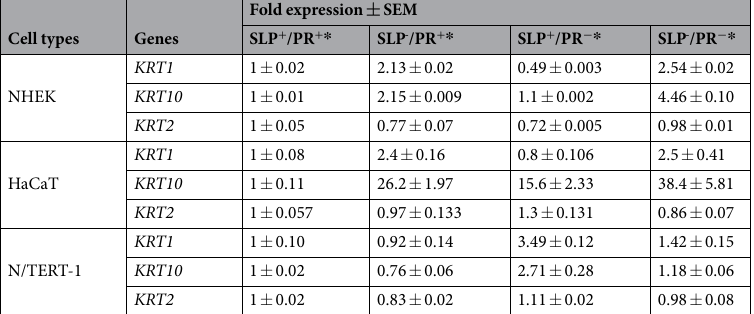
Table 1. mRNA expression of KRT1 , KRT10 and KRT2 in four different culture conditions in NHEK, HaCaT and N/TERT-1 cells. * SLP + /PR + : complete FCS with phenol red (PR); SLP − /PR + : charcoal stripped FCS (CS-FCS) with PR; SL + /PR − : complete FCS without PR; SLP − /PR − : CS-FCS without PR. Each experiment was performed at least in 3 independent replicates. Standard error of the mean (SEM) was calculated using Microsoft